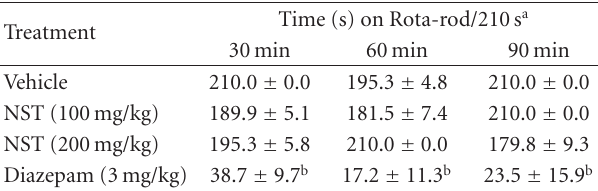
Table 3: E ff ect of NST or diazepam on the Rota-rod